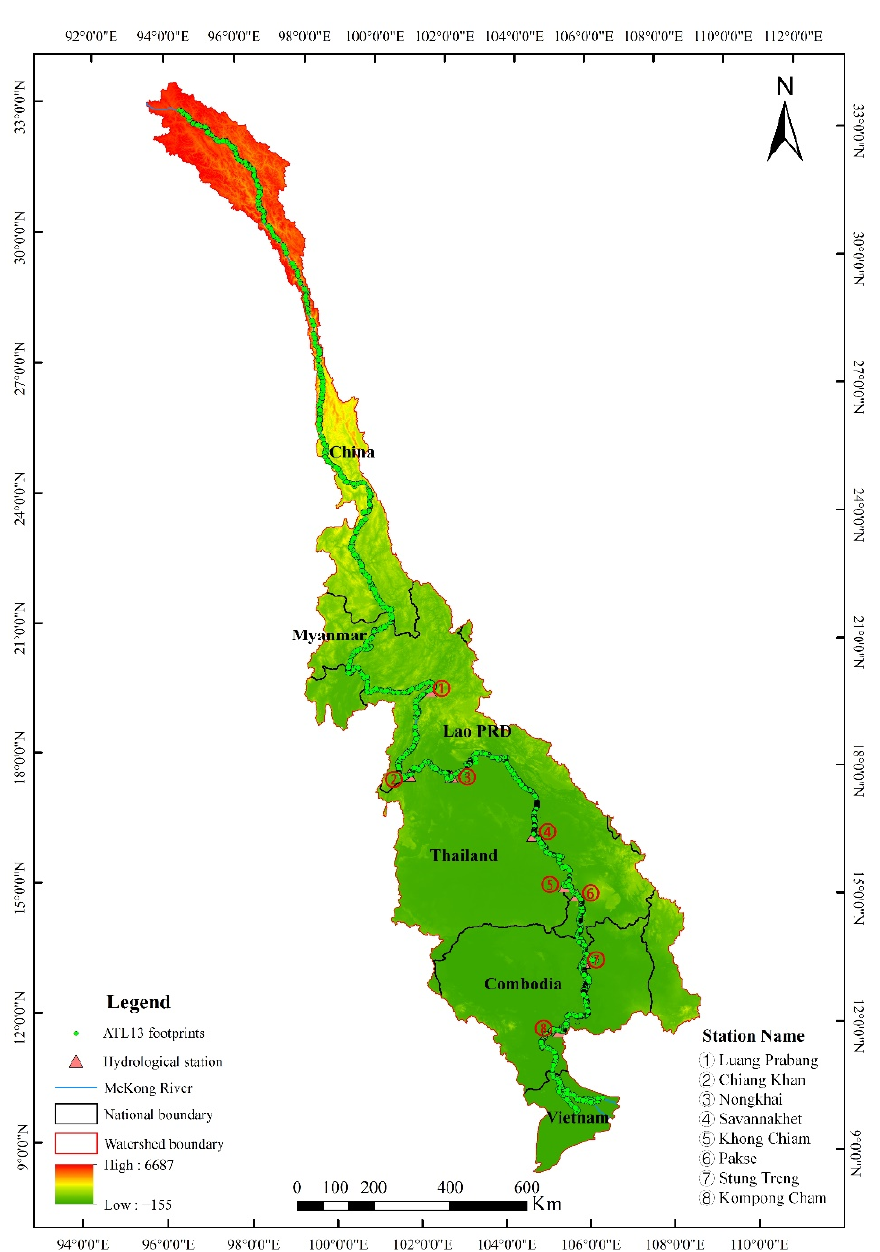
Figure 1. Map of the Mekong Basin showing elevation, mainstem of Mekong River and distribution of main hydrological stations. The Digital Elevation Model (DEM) was obtained from Google Earth Engine (GEE) platform and the shape files for the Mekong River and basin boundary were download from https://www.hydrosheds.org/ (accessed on 2 November 2021).